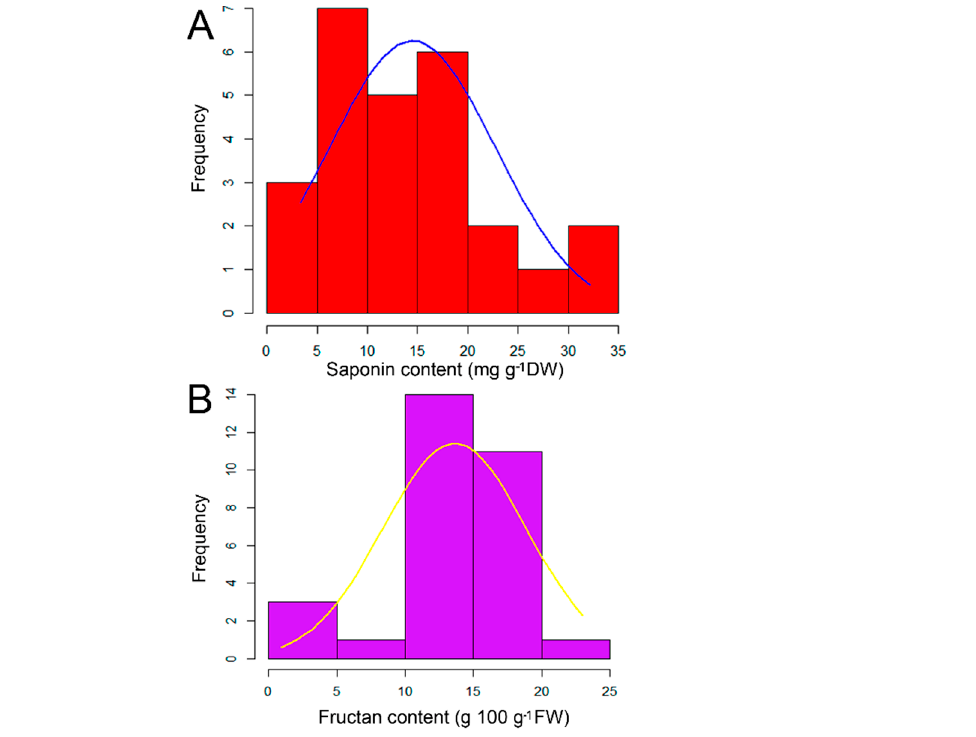
Figure 1. Histogram distribution of saponin ( A ) and fructan ( B ) contents in the investigated garlic accessions.